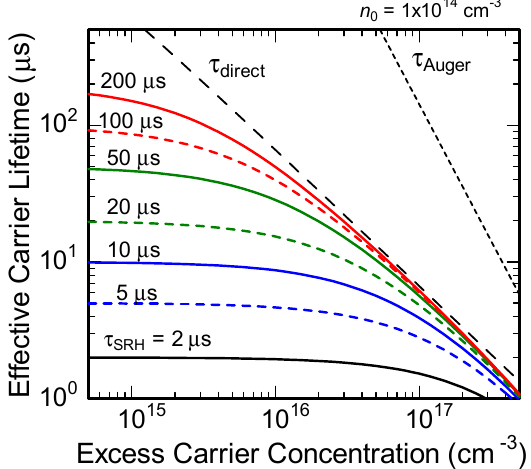
Figure 12. Effective carrier lifetime in SiC as a function of the excess carrier concentration.